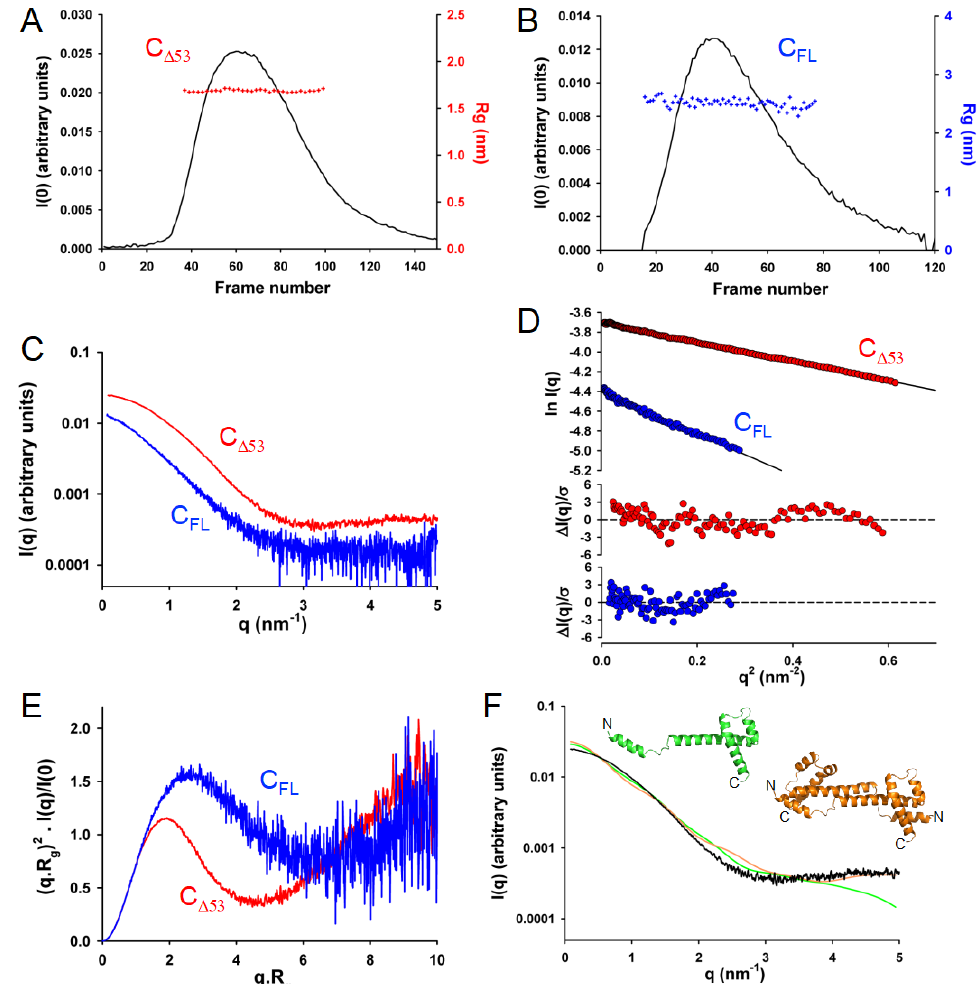
Figure 7. Small-angle X-ray scattering experiments. ( A ) SEC-SAXS analysis of TupV C Δ 53 protein. The black line shows the scattering at zero angles (I(0)), which is proportional to both molecular mass and concentration, as a function of the frames recorded at regular time intervals. The red crosses show the radius of gyration calculated from the Guinier plots at different time intervals. ( B ) SEC-SAXS analysis of TupV C FL protein. The black line and the blue crosses are as in panel ( A ). ( C ) Averaged scattering curves. The lines show the scattering profiles obtained for C Δ 53 (in red) and C FL (in blue) by averaging the individual profiles recorded throughout the SEC elution peak shown in panels ( A , B ). ( D ) Guinier plots. The upper panel shows the Guinier plots for C Δ 53 (in red) and C FL (in blue). The lower panels show the plots of the normalized residuals. ( E ) Normalized Kratky plots. ( F ) Comparison of TupV C Δ 53 protein in solution and in crystal. The experimental SAXS curve ob- tained for TupV C Δ 53 protein (black line) is compared to the theoretical curve calculated with CRYSOL for one monomer (green line) and one dimer (orange line) extracted from the crystal struc- ture (shown in cartoon representations in green and orange, respectively). The curves were scaled in order to simply compare their shape and not to take into account differences in molecular mass.